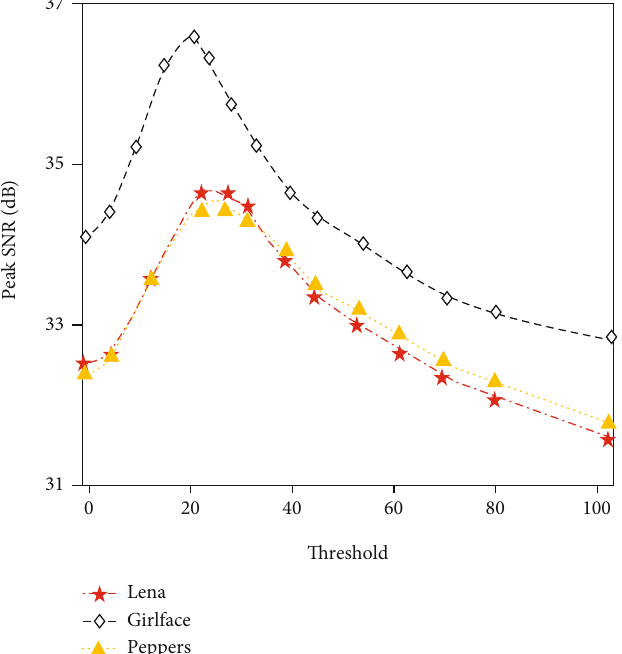
Figure 3: In fl uence of threshold TS on decryption